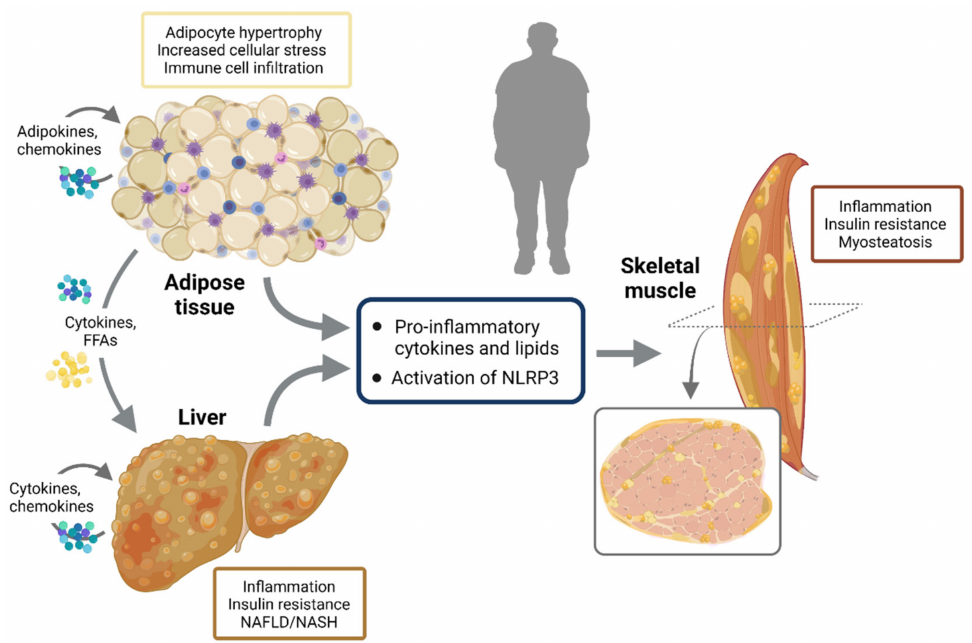
Figure 5. NLRP3 activation and interplay between insulin target tissues. In obesity, adipocyte hypertrophy induces cellular stress together with immune cell infiltration, release of inflammatory adipokines and insulin resistance. Once adipose tissue storage capacity is overwhelmed, ectopic lipid deposit occurs in several other tissues including the liver and skeletal muscle, further worsening inflammation and insulin resistance. This leads to NAFLD/NASH in the liver and to myosteatosis in skeletal muscle. NLRP3 plays a crucial role in metainflammation and in the interplay between these three insulin target